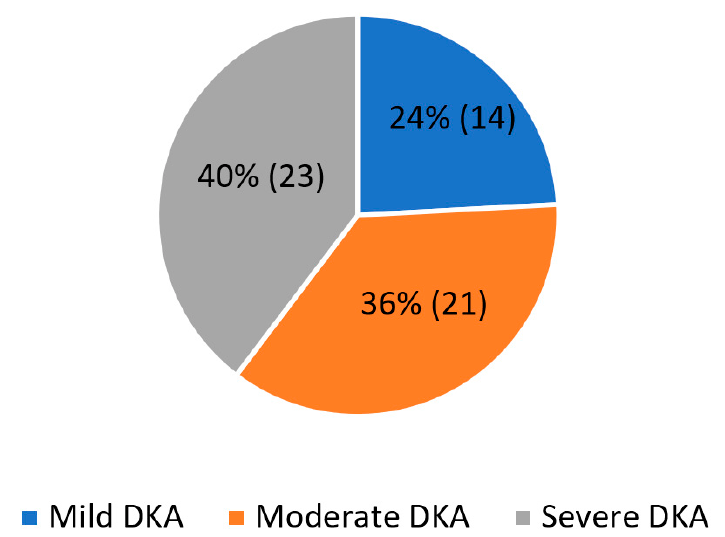
Figure 3. Number and percentage of children with diabetic ketoacidosis admitted in Pediatric Intensive Care Unit in the period 2011–2020, divided by severity of acidosis. Legend: DKA—diabetic ketoacidosis. During the first 24 h of treatment in the PICU, there were rapid changes in serum glucose concentration, pH, bicarbonate concentration, and serum carbon dioxide partial pressure levels. The fastest changes were recorded in the first eight hours of treatment (Figure